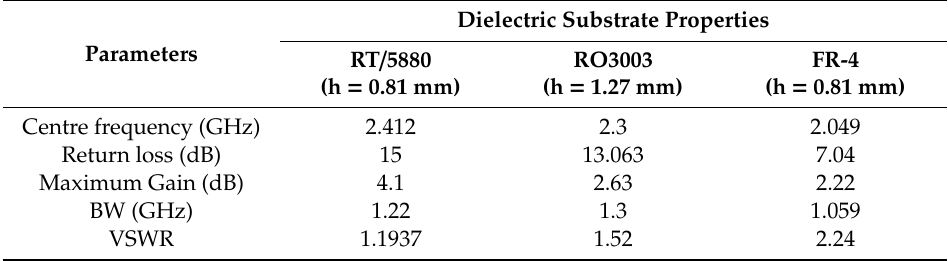
Figure 9. S 11 comparison for different dielectric substrate materials and different dielectric substrate heights. Table 3. Performance comparison of some of the parameters involved in the designed filter-antenna circuit using the three different dielectric substrate material types.